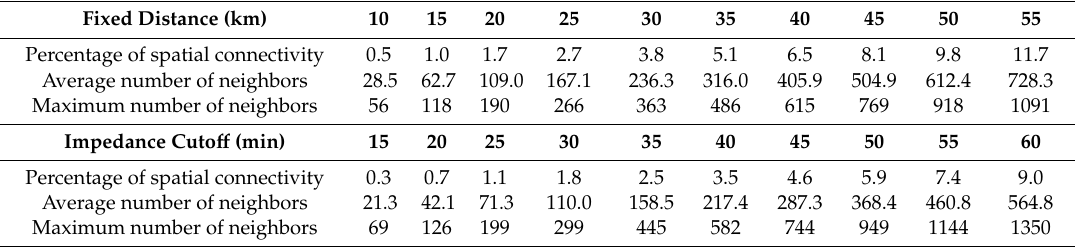
Table 1. Basic characteristics of distance-based spatial weights and time-based network spatial